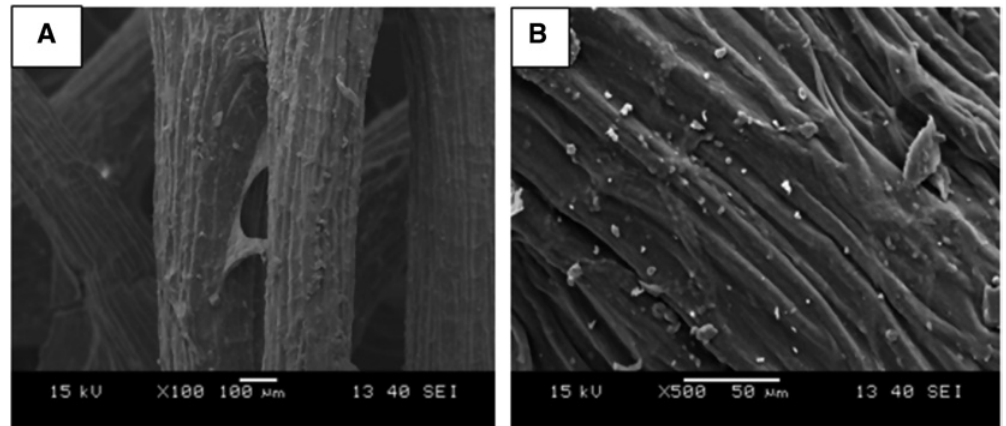
Figure 7: SEM micrographs of the untreated luffa cylindrical fiber for magnification (A) × 100 and (B) ×